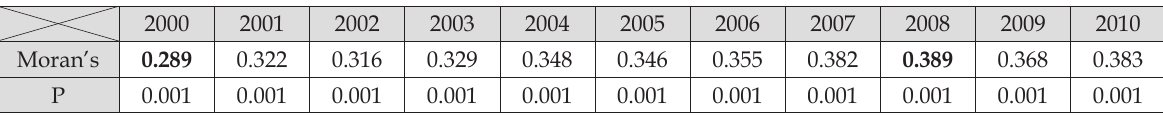
Table 5. Values of the global Moran’s I statistic and its significance level by NUTS 4 units in the years 2000– 2010: a general approach